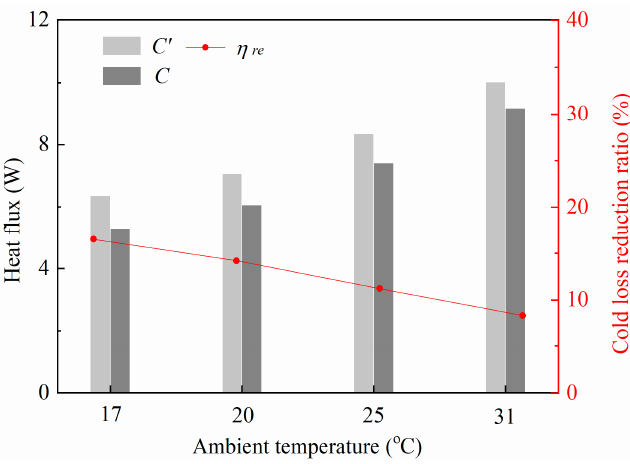
Figure 7. Cold loss recovery performances of modified freezer at various ambient temperatures.